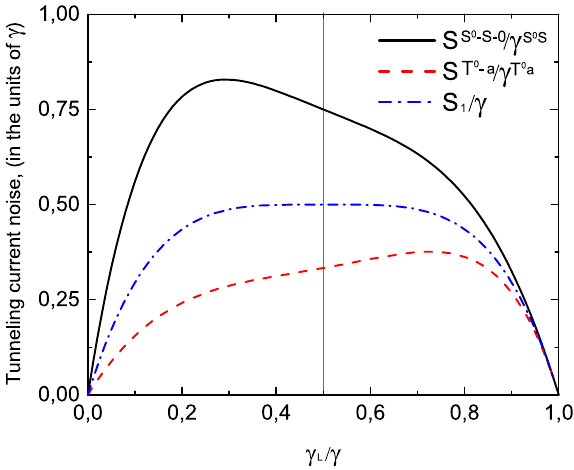
Figure 9. Zero frequency noise as a function of tunneling contact asymmetry γ T 0 a L /γ T 0 a γ S 0 S L /γ S 0 S γ S L /γ S ) for a single type of carriers S 1 /γ (blue dashed-dotted curve), for ( γ L /γ = = = 0 a channel S T 0 a /γ T 0 a (red dashed curve) and for the S 0 the T − 1 . Temperature is equal to 0.01 ε curve). U / T ≫